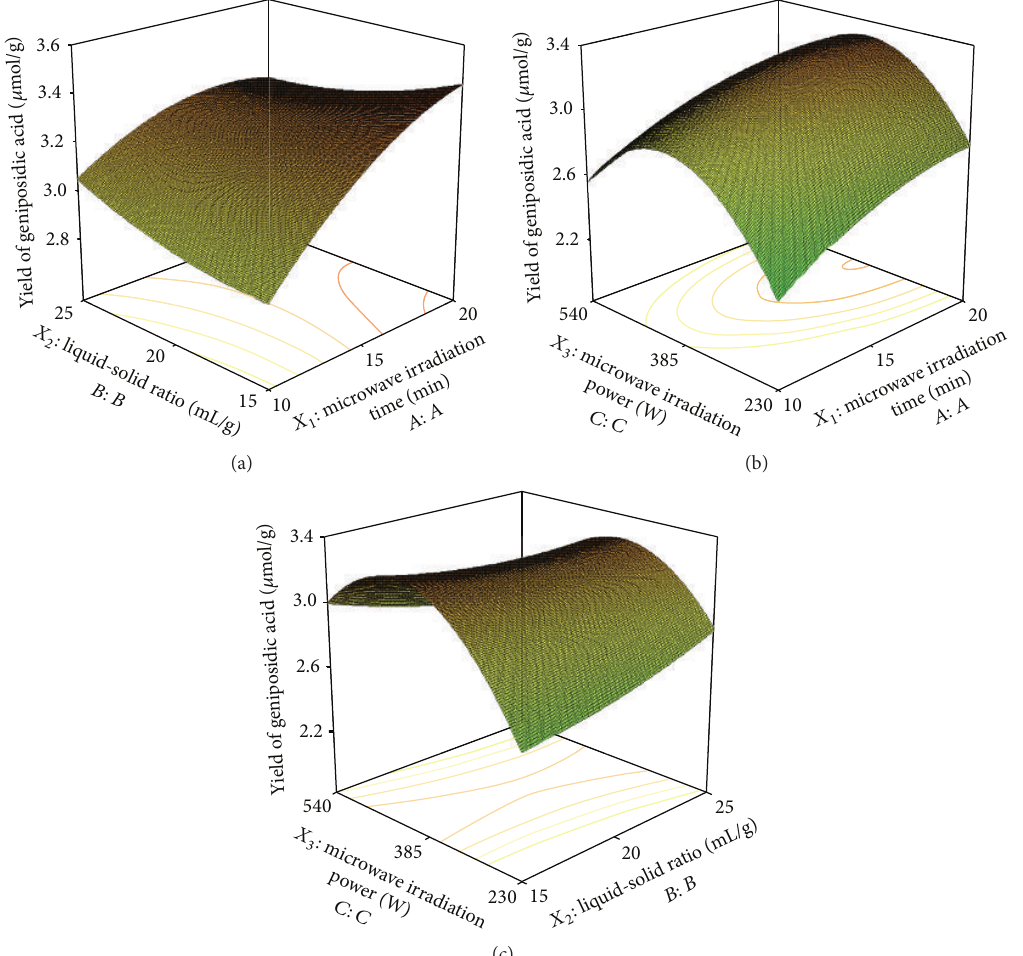
Figure 4: Three-dimensional response surface plots for the effect of independent variables on yield of geniposidic acid: (a) microwave irradiation time (min) and liquid-solid ratio (mL/g); (b) microwave irradiation time (min) and microwave irradiation power (W); (c) microwave irradiation power (W) and liquid-solid ratio